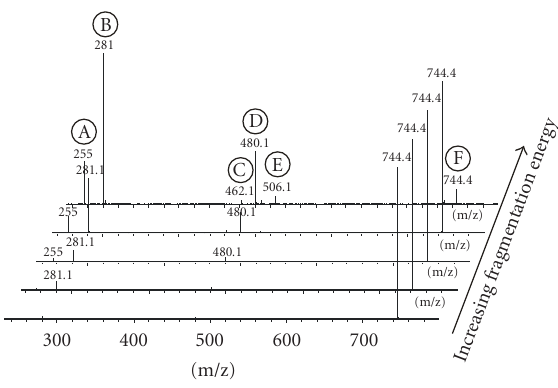
Figure 1: Variation of the fragmentation energy of negative ion mode ESI-MS 2 of POPC